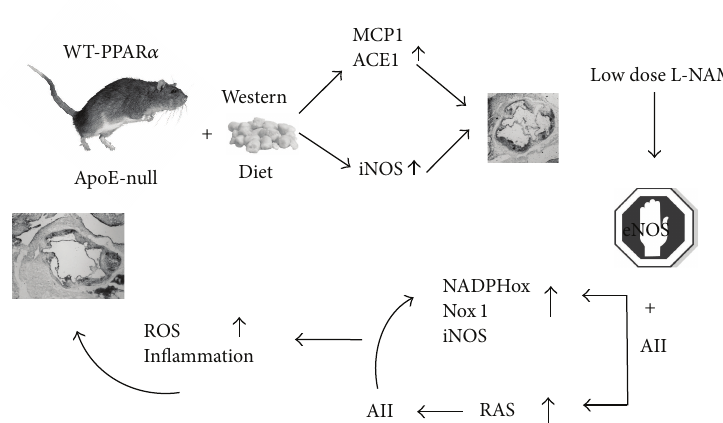
Figure 5: Proposed mechanism for the collusion of PPAR 𝛼 and AII in the ApoE-null mouse with wild type (WT) PPAR 𝛼 gene. The preferential eNOS activity inhibition by low dose L-NAME is suggested to alter the balance between AII and endothelium-derived NO, allowing amplification of the proatherogenic effect of unopposed AII